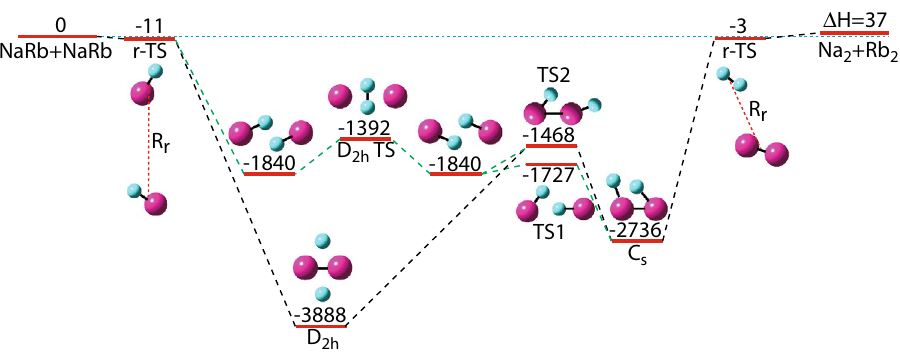
Figure 1. Energies of stationary points for the 23 Na 87 2 Rb 2 ground-state potential based on coupled-cluster calculations with all four atoms located in the same plane, i.e. have C s symmetry. All energies are given in units of hc × 1 cm − 1 . The energy is zero for two 23 Na 87 Rb molecules at their equilibrium separation of the X 1 (cid:31) + state. This state is shown on the left-hand side of the figure. The right-hand side shows the endothermic di-atomic 23 Na 2 + 87 Rb 2 ground-state limit at the respective equilibrium separations. Other stationary states, minima and saddle points, in the PES (red horizontal lines) are shown in between. Saddle points are labeled by the abbreviations TS and r-TS corresponding to transition states and roaming transition states, respectively. For all stationary states a diagram shows the location of the four atoms. Na and Rb atoms are indicated by small cyan and large magenta spheres, respectively. Dashed black and blue lines connect stationary states and